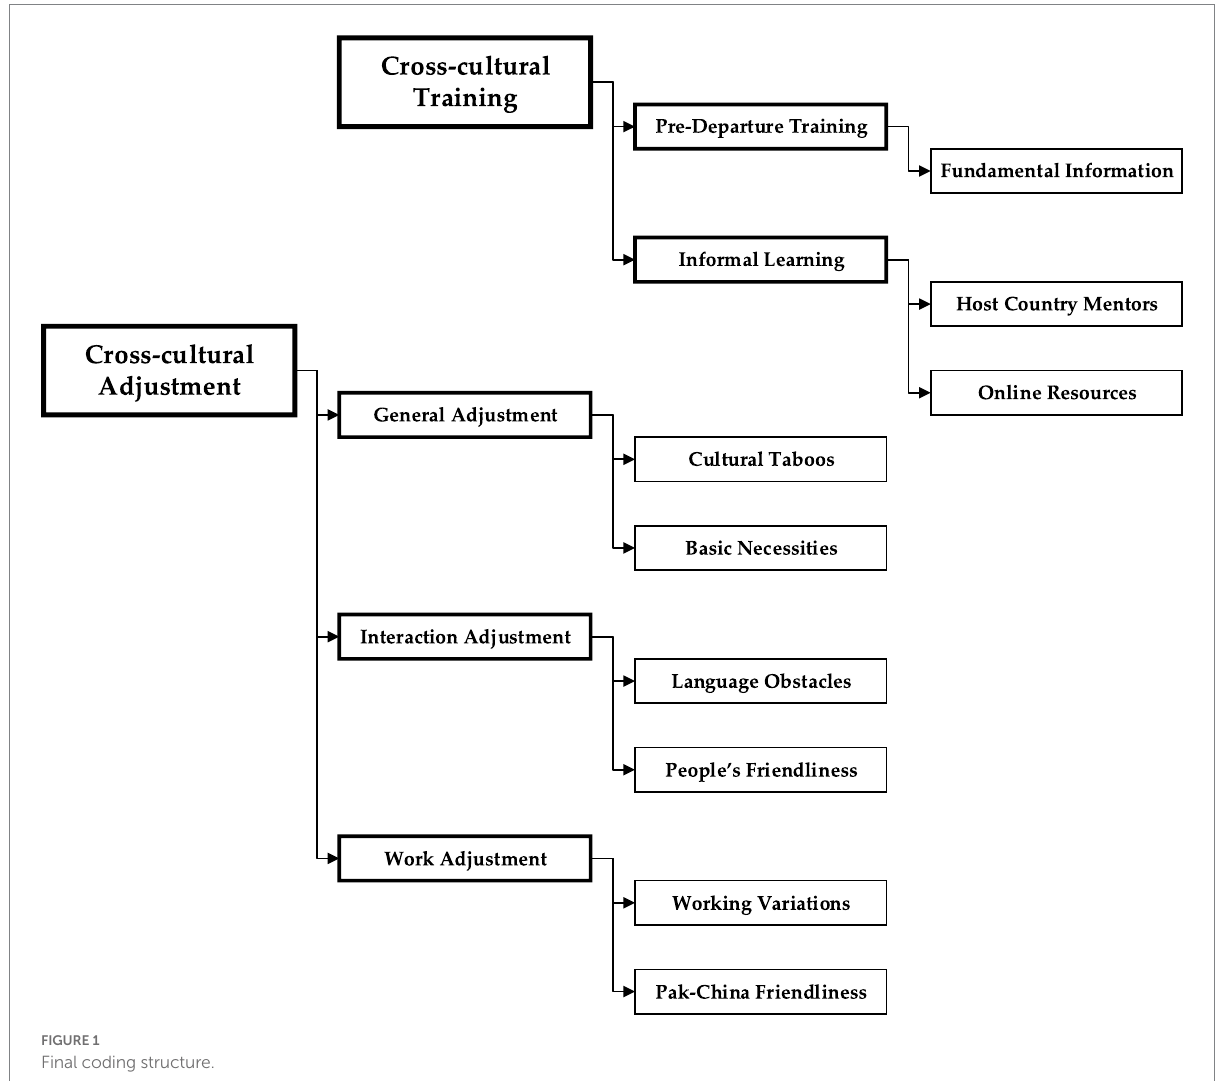
FIGURE 1 Final coding